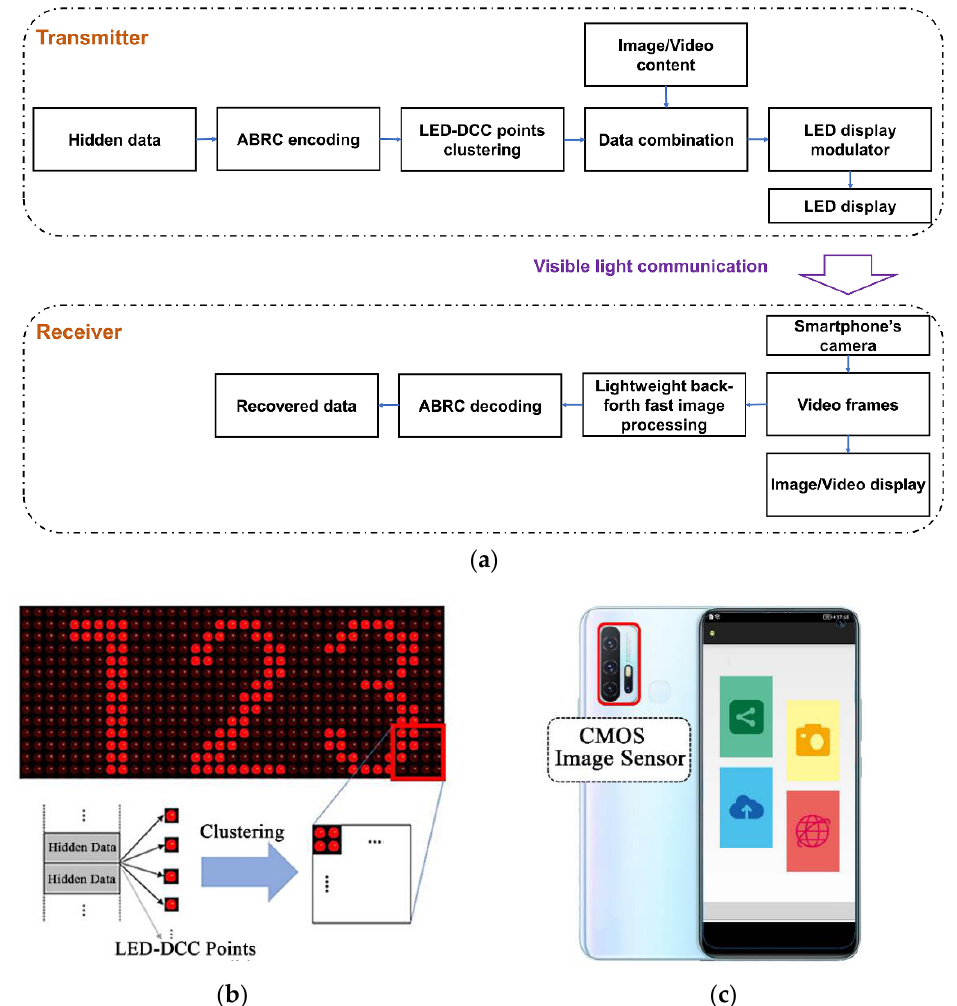
Figure 1. ( a ) The overall block diagram of the proposed long-distance, real-time LED-DCC system. ( b ) LED displays for displaying and communication. ( c ) Smartphone’s CMOS camera for receiving VLC signals.